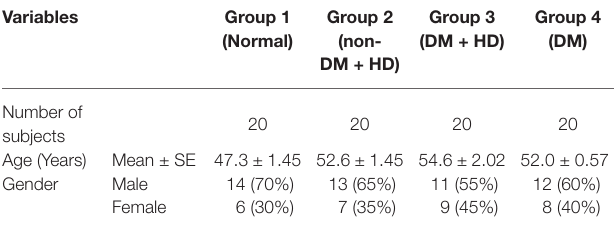
TABLE 1 | Demographic data of studied